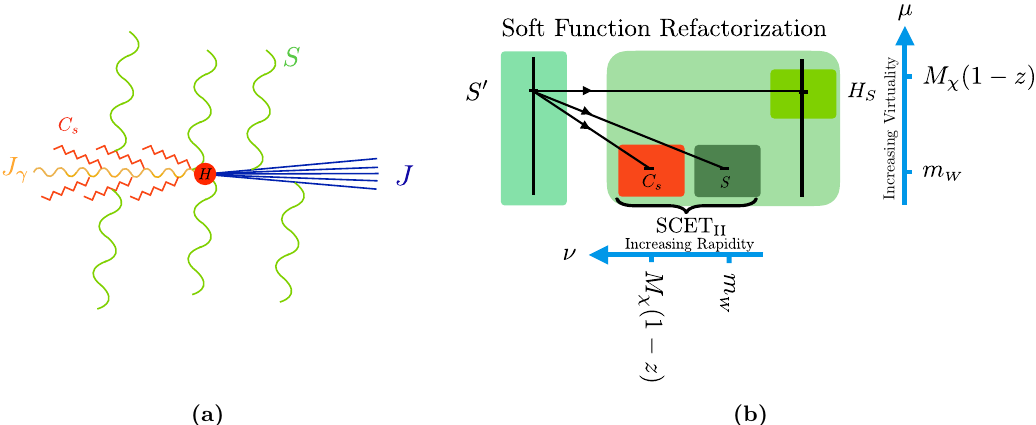
Figure 3 . A review of the refactorization of the soft function derived at LL accuracy in [15]. In this paper we prove that this refactorization is also valid at NLL. (a) A schematic depiction of the refactorization of the soft function into di(cid:11)erent modes, illustrating their physical interpretation. (b) The virtuality and rapidity of the di(cid:11)erent modes appearing in the factorization formula. the bosons at the scale m are color entangled with those at the scale M (cid:31) (1 z ). (In W (cid:0)